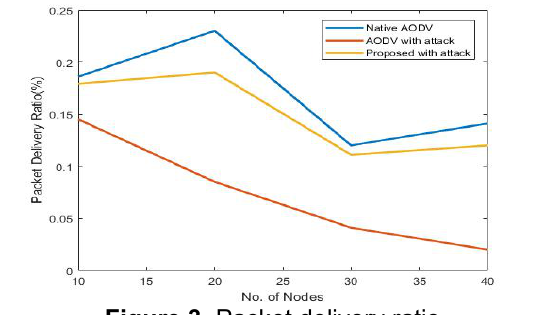
Figure 3. Packet delivery ratio